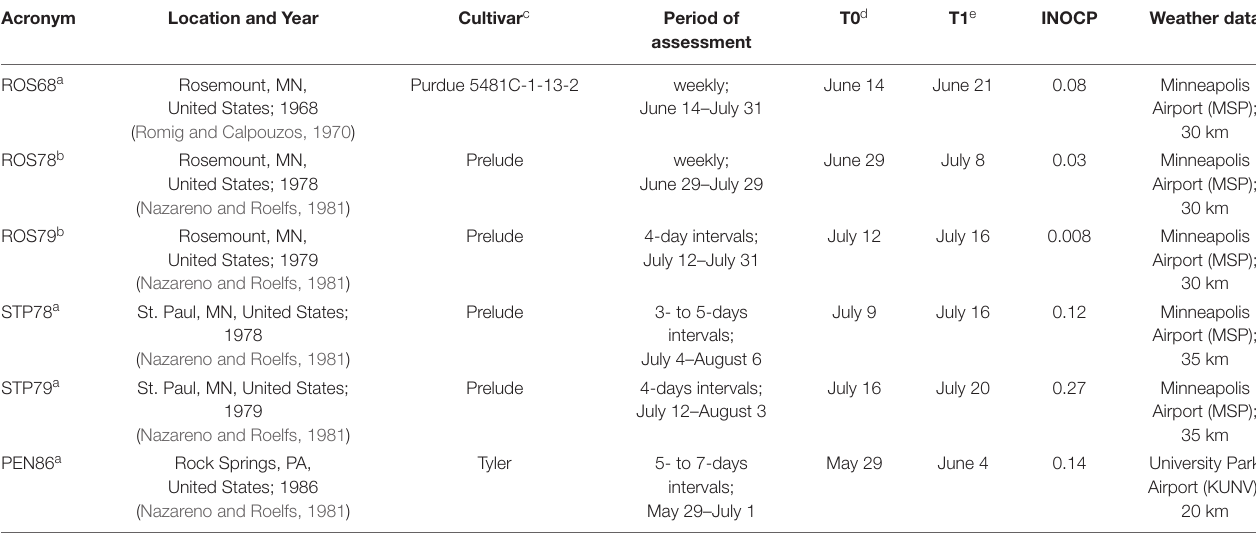
TABLE 3 | Experimental sites (acronyms for locations and years), wheat cultivar, period of disease assessment, INOCP (value of primary inoculum used to initialize model calculations), and weather data used to validate model predictions of epidemic development.